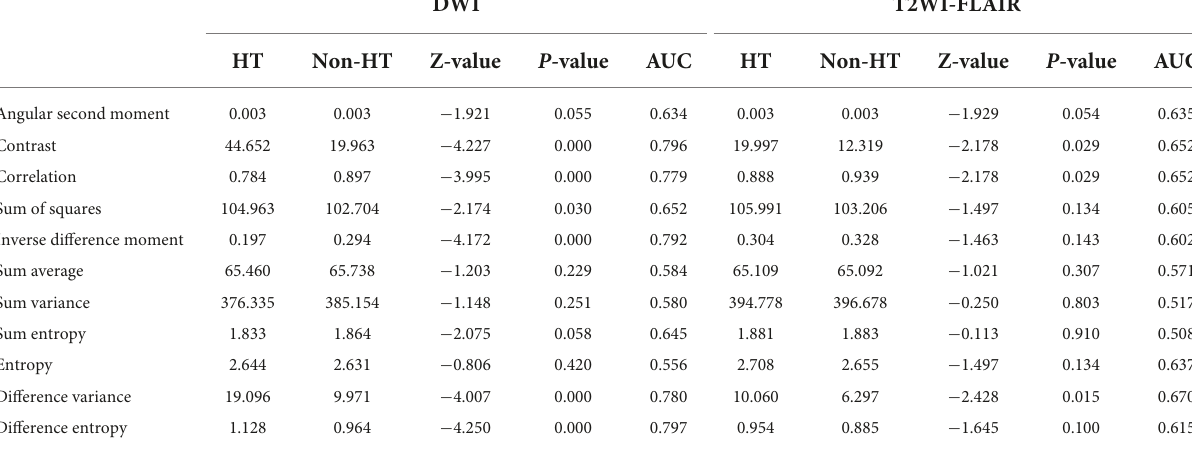
TABLE 2 Comparison of textural parameters of diffusion-weighted image (DWI) and T2-weighted-fluid-attenuated inversion recovery (T2/FLAIR) images between hemorrhagic transformation (HT) and non-HT groups and receiver operator characteristic (ROC) analysis. DWI